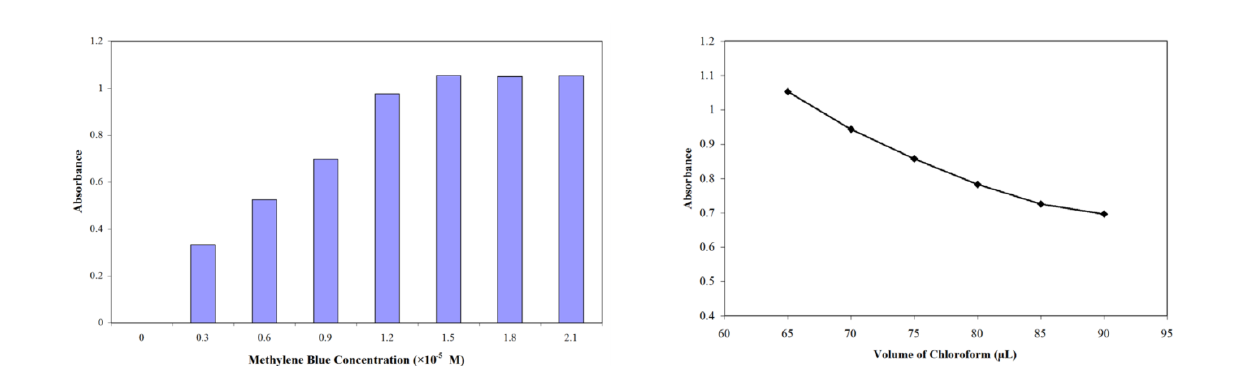
Figure 1. Effect of MB concentration on the absorbance of AS-MB ion- pairs obtained from DLLME. Extraction conditions: volume of water sample, 5.0 mL; volume of disperser solvent (ethanol), 2.00 mL; volume of microextraction solvent (chloroform), 138 µL; SDS amount, 0.04 mg L -1 .